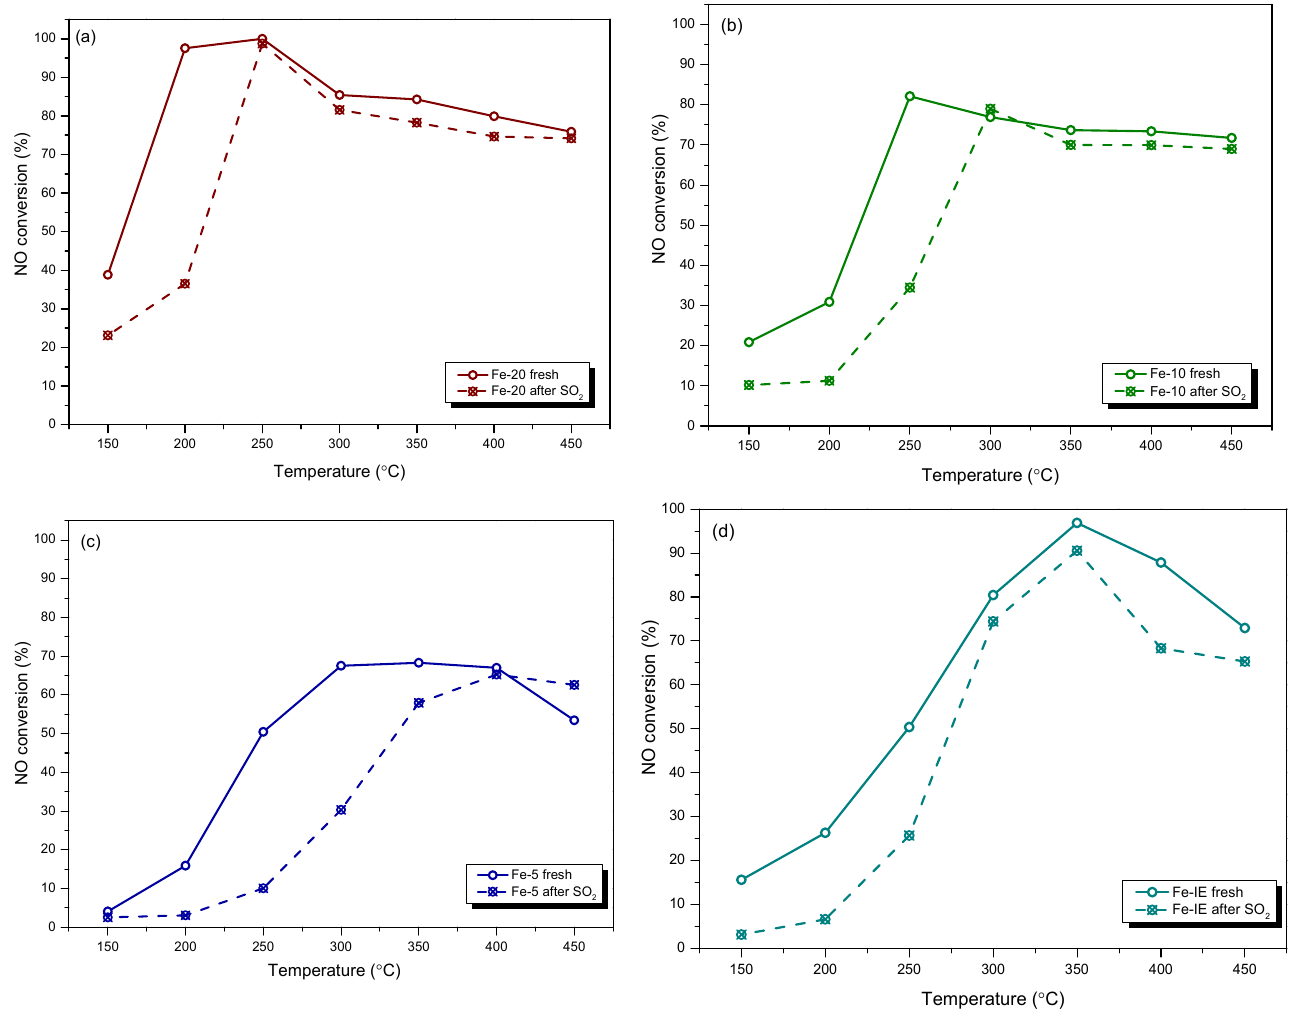
Figure 3. NO conversion obtained for the fresh and SO 2 -poisoned catalysts: ( a ) Fe-20; ( b ) Fe-10; ( c ) Fe-5; ( d ) Fe-IE.